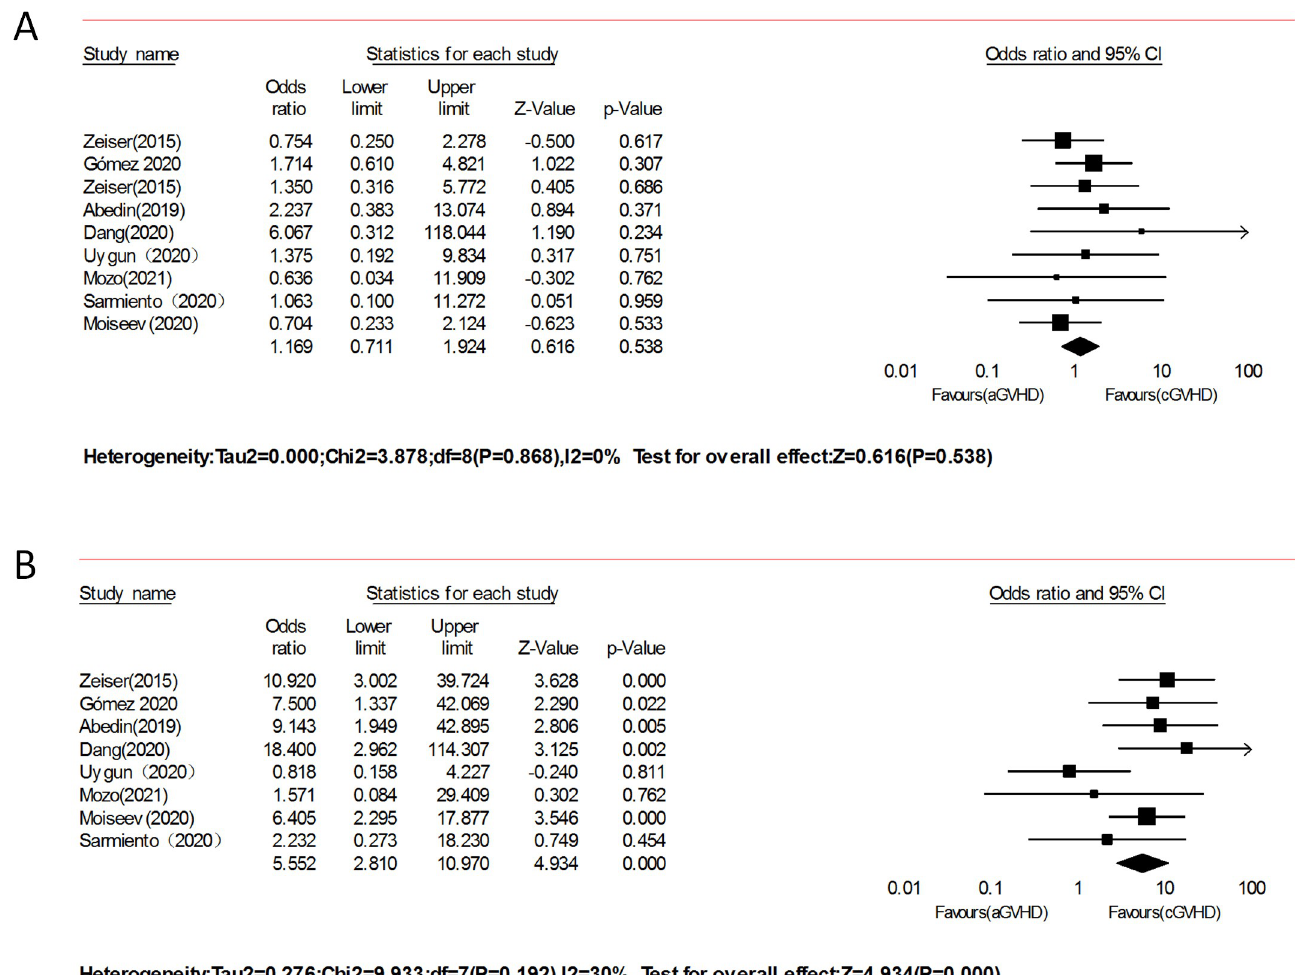
Fig 6. Forest plots of the overall response (ORR) of aGVHD vs. cGVHD after ruxolitinib